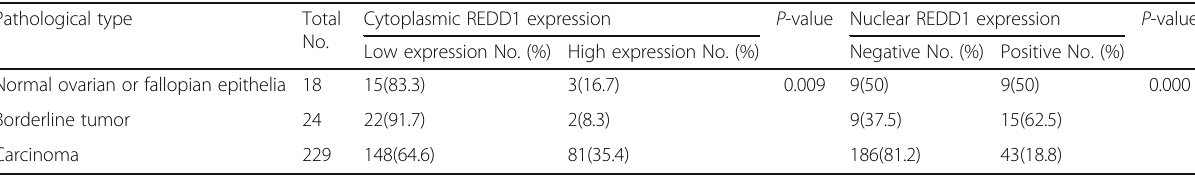
Table 1 REDD1 expression in different ovarian epithelial tissues Pathological type